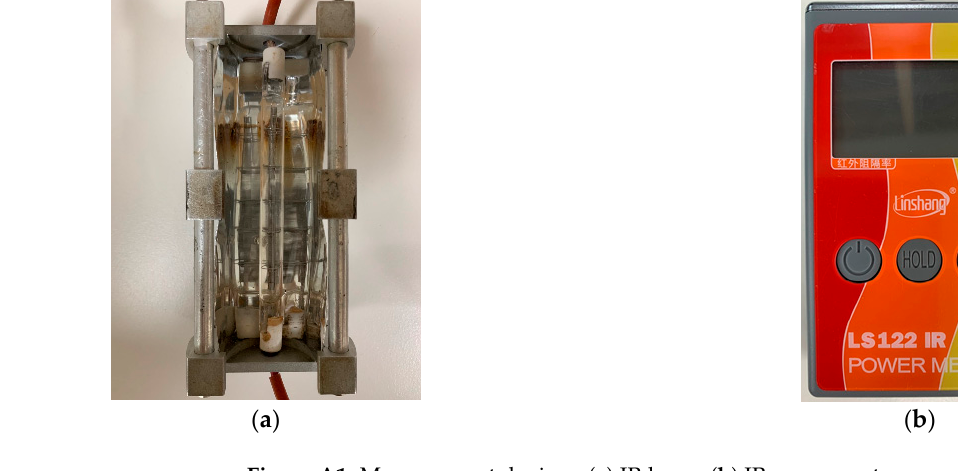
Figure A1. Measurement devices: ( a ) IR lamp; ( b ) IR power meter.